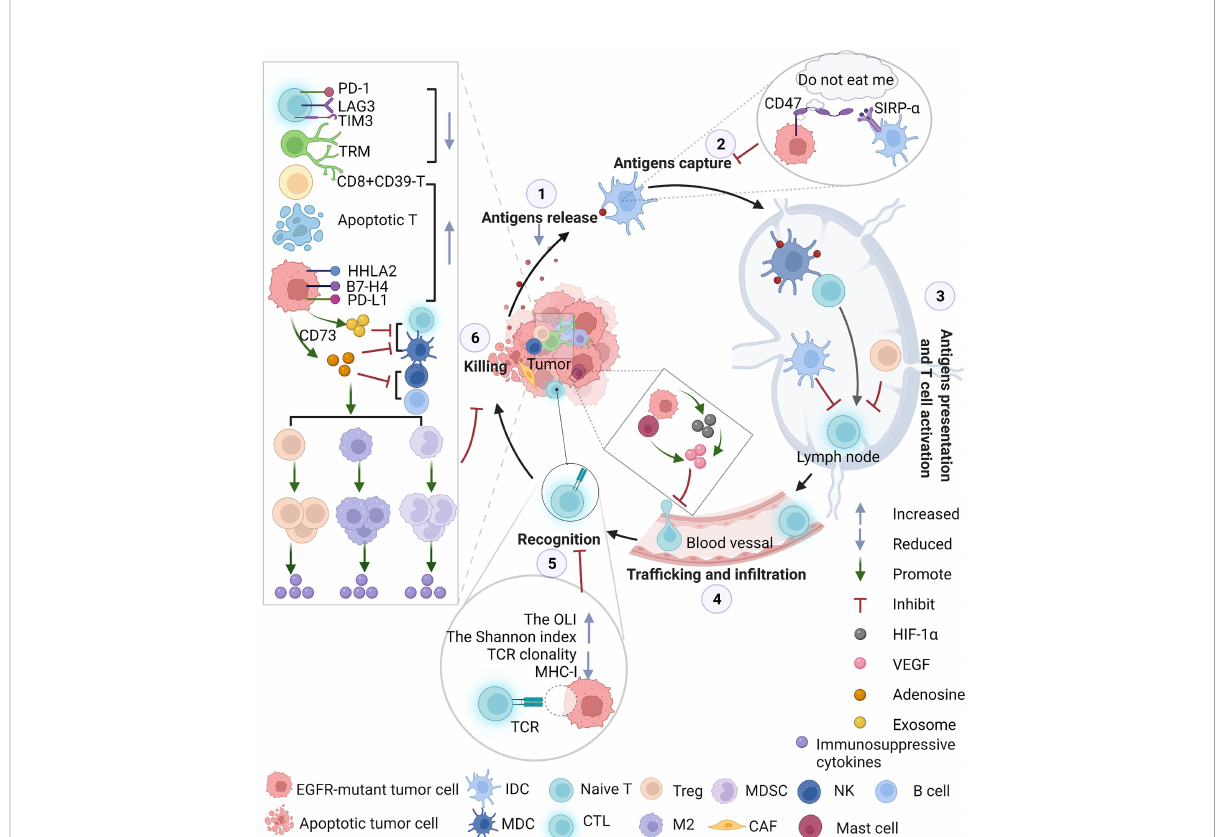
FIGURE 2 The immunosuppressive TME throughout the whole cancer-immunity cycle in EGFR-mutant NSCLC. EGFR activation alters immune pro fi les through the following pathways: the surface of cancer cells creates a “ do not eat me ” signal that inhibits professional phagocytic cells, such as dendritic cells (DCs), from engul fi ng cancer cells due to the presentation of tumor antigens; promotes CTLA-4 expression to enhance the inhibitory function of Tregs; increases the in fi ltration of Tregs in the TME and promotes tumor growth; increases mast cells that contribute to angiogenesis and induces neovascularization by releasing proangiogenic factors; decreases CD8 + T-mediated antitumor activity, inhibiting the expression of MHC (Figure 2); enhances T-cell apoptosis, promoting the M2-like polarization of macrophages and increasing the levels of IL-10, CCL13, GDF15, CCL23, CXCL17, TGF- b , soluble PD-L1 and CCL2. CCL2 plays a critical role in the migration of MDSCs to the TME. MDSCs exert antitumor immunosuppressive actions, such as producing immunosuppressive molecules, inhibiting antitumor functions, inducing T-cell apoptosis, and upregulating Tregs. CAFs, with characteristics of MDSCs, in EGFR-mutant NSCLC might interfere with the immune response. EGFR-mutant tumors secrete exosomes containing EGFR mutations or PD-L1 to promote distant metastasis. EGFR-mutant tumor cells may change metabolic pathways, such as upregulating CD73 and converting ATP to adenosine. Massive adenosine exerts immunosuppressive activity on a variety of immune cells: Tregs and accumulation of MDSCs, further attenuating antitumor function in NKs, B cells and DCs activity, skews M j polarization toward M2 macrophages and inhibits the CTL-mediated antitumor response, mediating tumor immune evasion. NKs, natural killer cells; DCs, dendritic cells; IDC, immature dendritic cells; MDC, mature dendritic cells; Tregs, Treg cells; MHC, major histocompatibility complex; MDSC, myeloid-derived suppressor cells; EGFR, epidermal growth factor receptor; TME, tumor microenvironment; ATP, adenosine triphosphate; PD-L1, programmed death-ligand 1; M j , macrophages; CTL, cytotoxic T